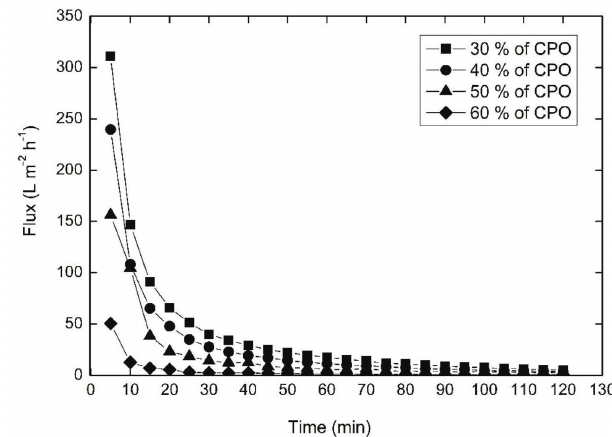
Fig. 4 – Permeate flux profile in the UF of the CPO-isopro- panol mixture at various concentrations of CPO (feed tempera- ture: 29 °C, transmembrane pressure: 1